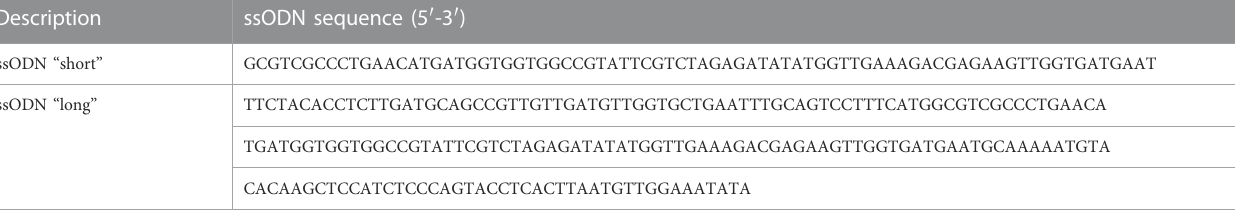
TABLE 5 List of homology arms used in this study for Panagrolaimus sp. PS1159 unc-22 .